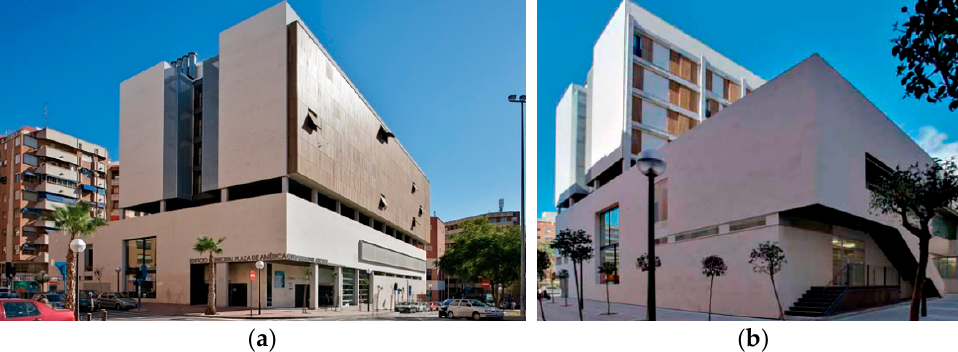
Figure 12. Plaza de América building’s main façade looking towards Plaza de América Square ( a ) Figure 12. Plaza de Am é rica building’s main façade looking towards Plaza de Am é rica Square ( a ) and rear façade ( b ). and rear façade ( b ). Courtesy of Patronato Municipal de la Vivienda de Alicante. Courtesy of Patronato Municipal de la Vivienda de Alicante.